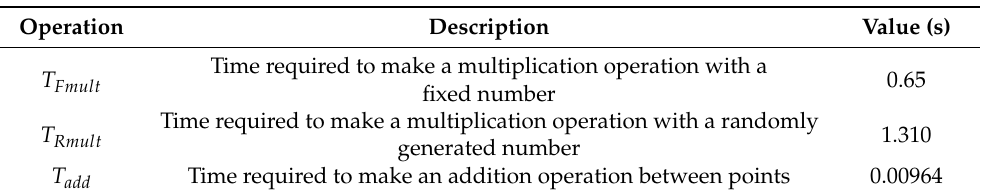
Table 5. The time required for operations on points of an elliptic curve according to [37] on the MSP430F1611